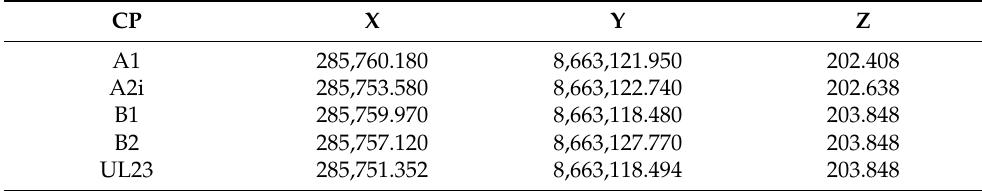
Table 3. Control points